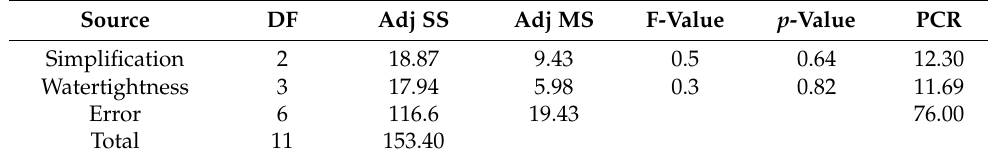
Table 3. ANOVA for volumetric error (Mode A).